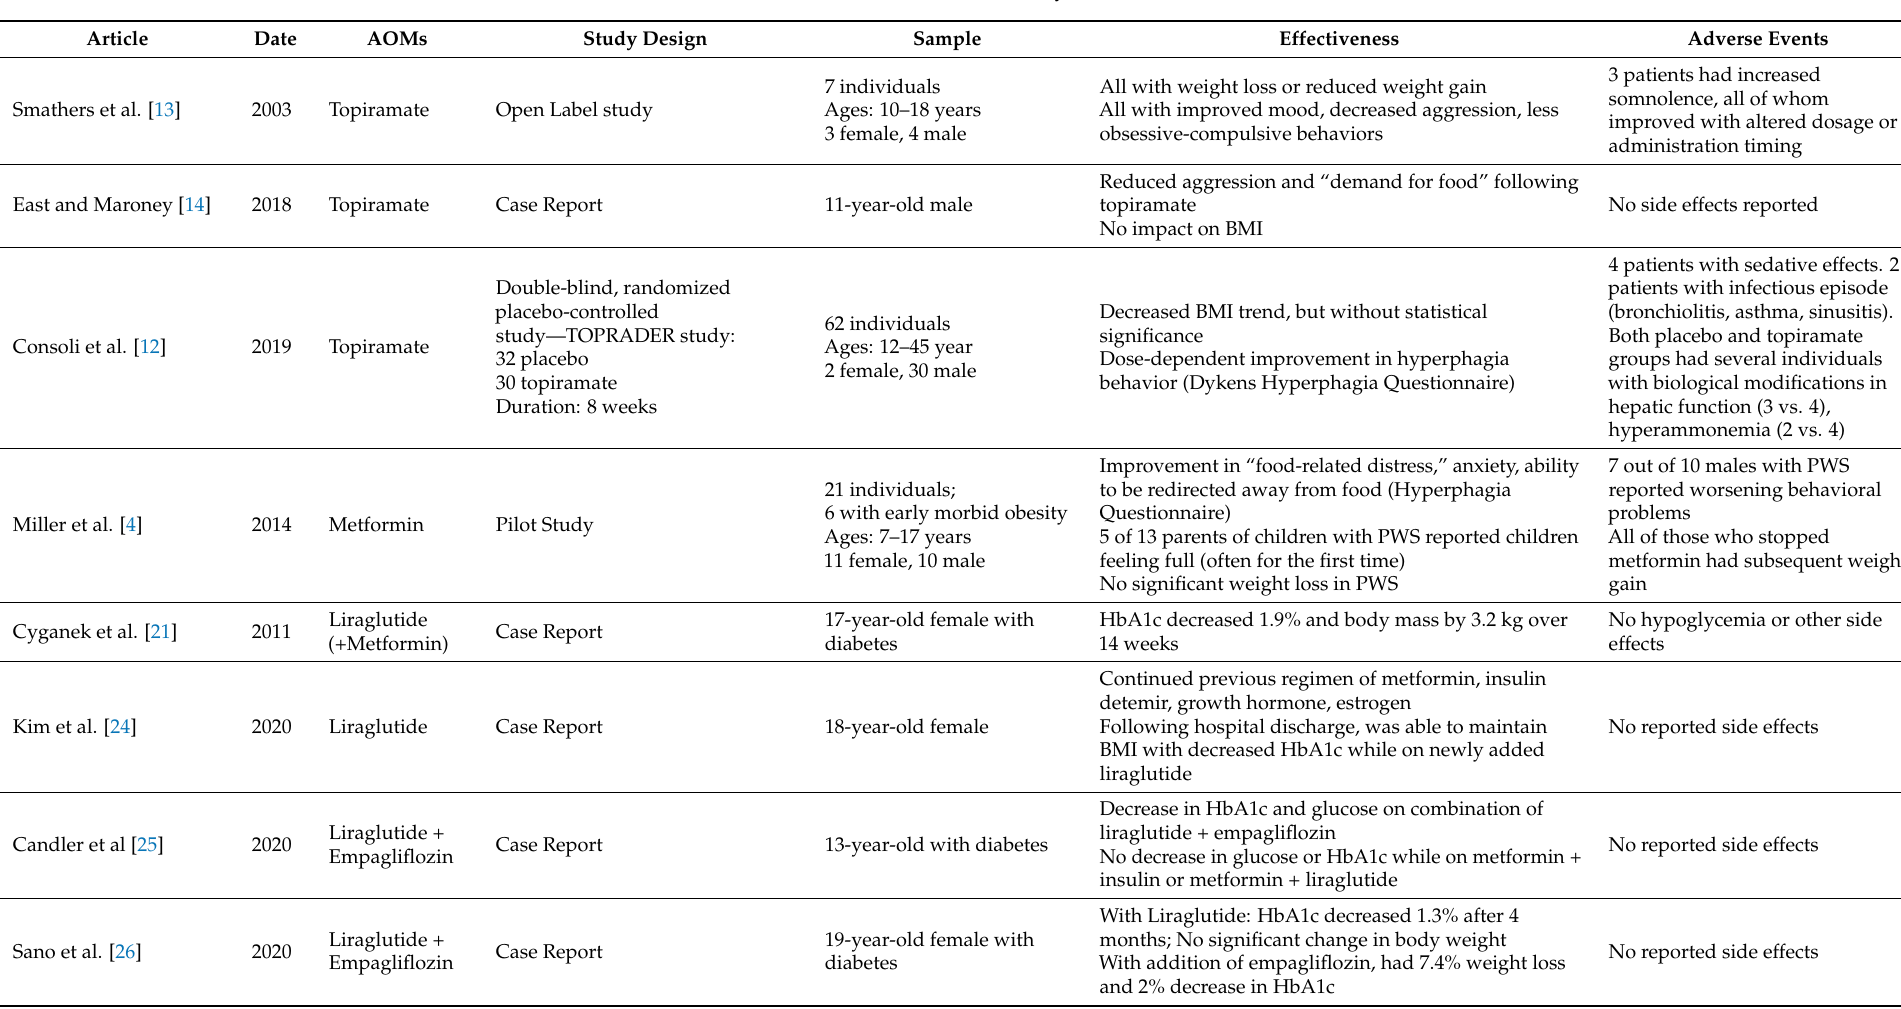
Table 2. Literature Review and Study